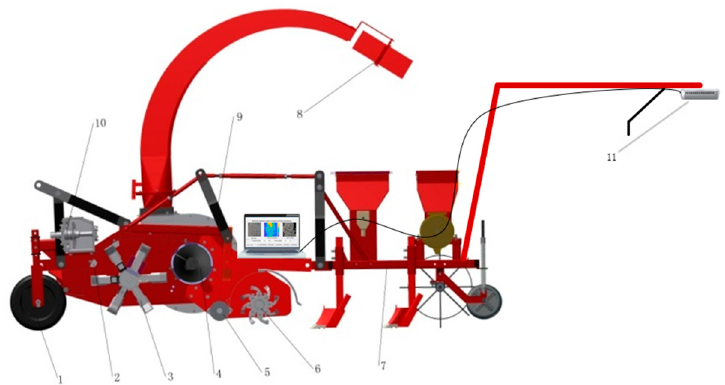
Figure 1. 1—Depth wheel; 2—Main frame; 3—Crushing straw device; 4—Transverse conveyor; 5—Ground Wheel; 6—Field cleaning (shallow spin); 7—Sowing and fertilizing device; 8—Even spreading device; 9—Intermediate coupling; 10—Gearbox; 11—RGB-D sensor.